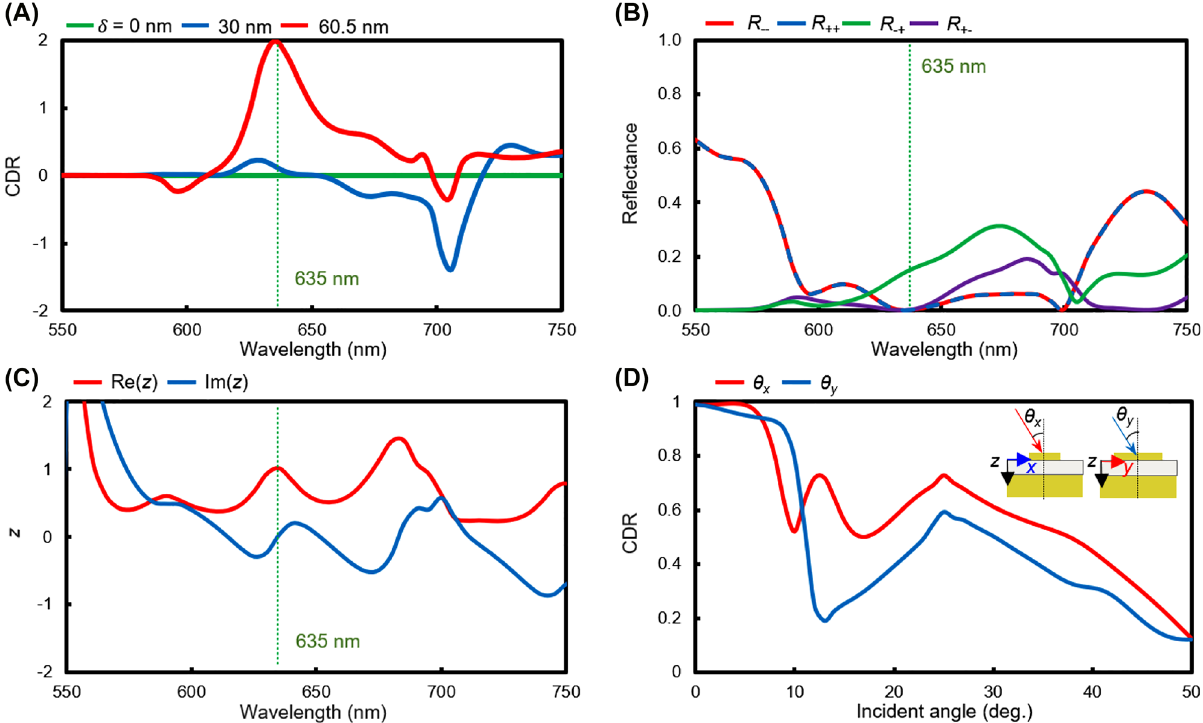
Figure 3: Chiroptical responses of the gap-shifted SRR. (A) Calculated circular dichroism in reflection (CDR) when the gap displacement δ is variedas0,30,and60.5nm.(B)Re fl ectancecomponentsofthegap-shiftedSRR( δ =60.5nm).(C)Calculatedeffectiveimpedance z ofthegap- shifted SRR ( δ = 60.5 nm) under RCP incidence. The dotted green line indicates the wavelength of 635 nm, where the metasurfaces perfectly absorb incident RCP. (D) Calculated CDR of the gap-shifted SRR ( δ = 60.5 nm) depending on the incident angle from 0 to 50 ⁰ . θ x and θ y denote incident angles with respect to the yz- and xz- plane,